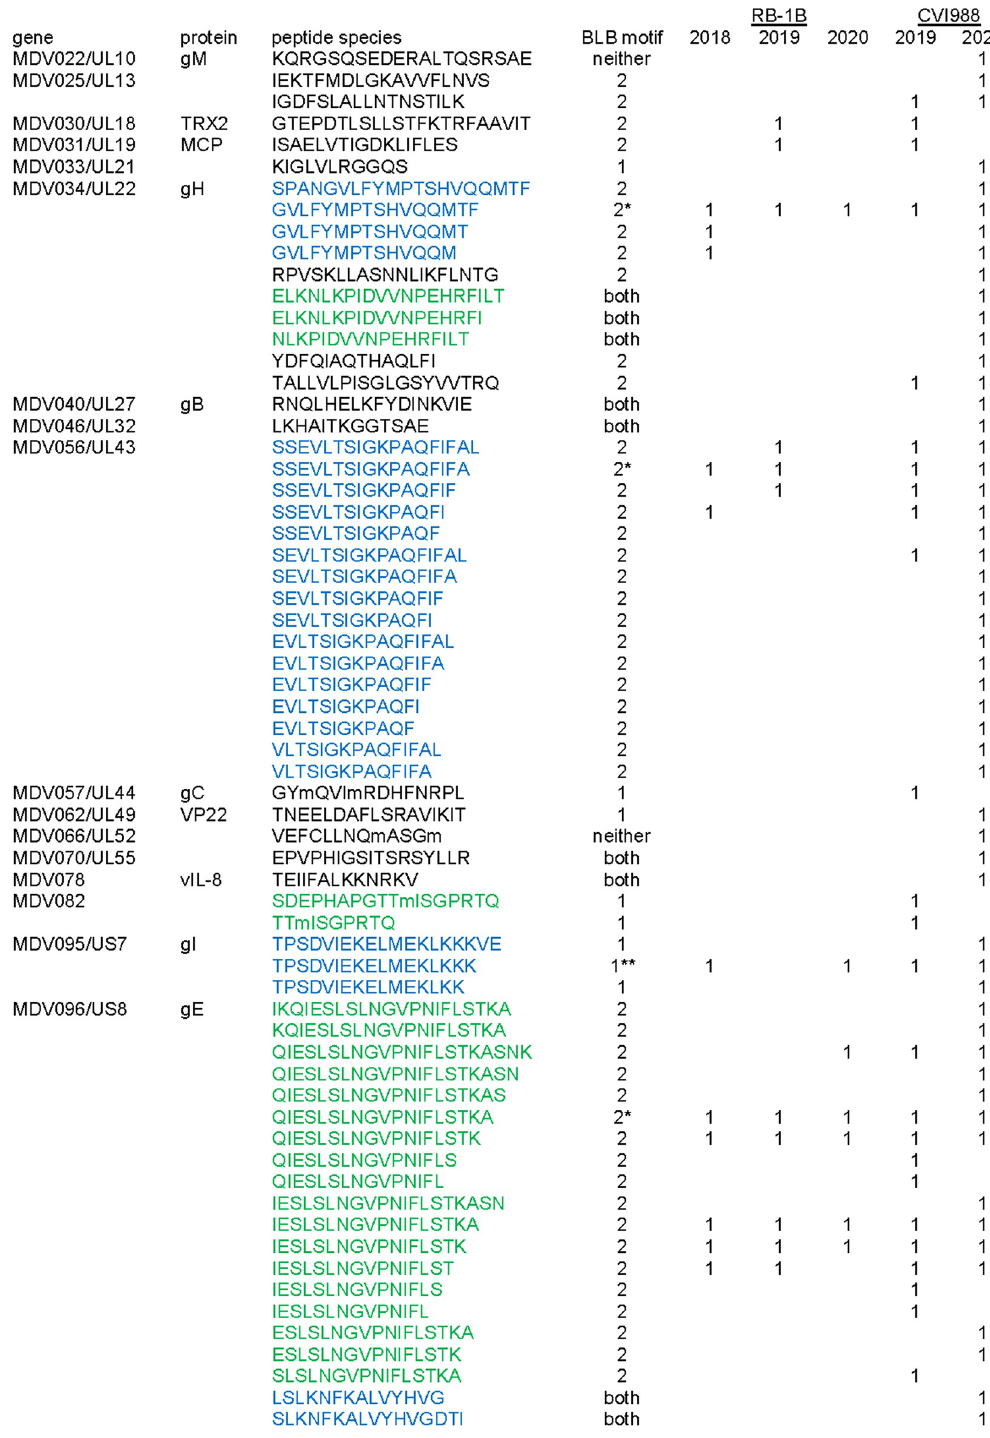
Fig 2. Peptides from class II molecules of bursal B cells infected in vitro. Proteins and peptides in order of the genomic sequence; blue, green indicate multiple species from same peptide epitope; soluble BL linked with BLB2: � expressed, �� not expressed; peptide species found in particular experiment indicated by